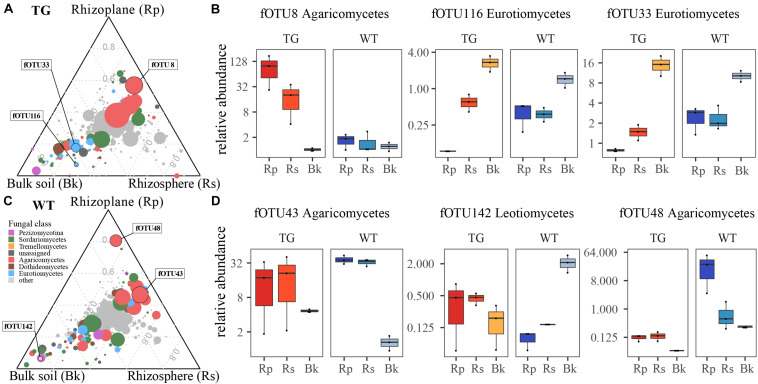
(A,C) Identifying fungal operational taxonomic units (fOTUs) that vary in abundance in response to different soil compartment in two sugarcanes. (B,D) The relative abundances of a few representatively responsive fOTUs in rhizoplane, rhizosphere, and bulk soil compartments, which are also indicated in the ternary plots.